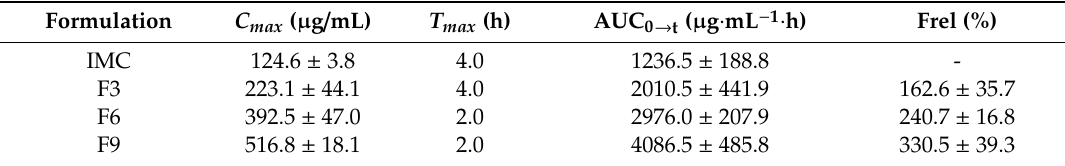
Figure 8. Mean drug concentration-time profiles of IMC, IMC–MSNs (F3), IMC–MSNs@Kollicoat IR (F6), and IMC–MSNs@HPMC (F9) in rats after oral administration (mean ± SD, n = 3). Unpaired Student’s t -test was used to do statistical analysis. Statistical significance was set as * p < 0.05, compared to the IMC group. Table 3. Pharmacokinetic parameters of IMC after oral administration of di ff erent IMC–SDs at a dose of 40 mg / kg to rats (mean ± SD, n =